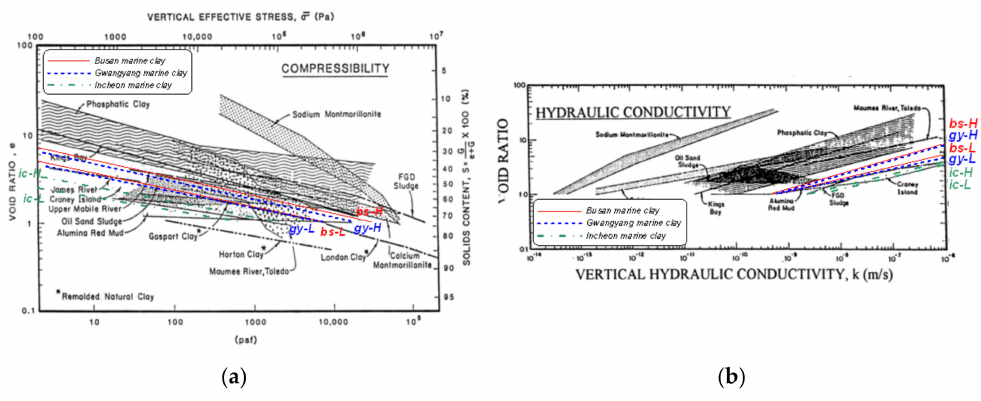
Figure 16. Comparison of our study and the study by Carrier et al. [10]: ( a ) void ratio vs. e ff ective stress; ( b ) void ratio vs. permeability.